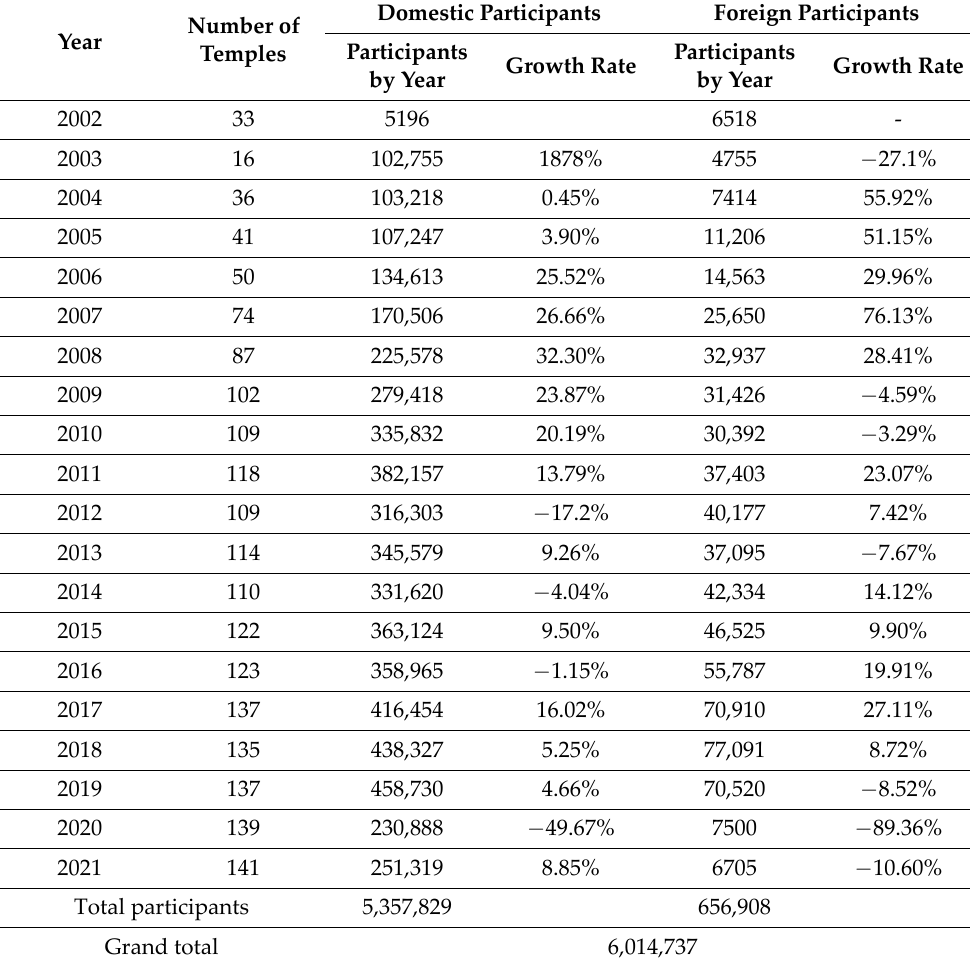
Table 1. The number of temples and participant statistics by year of